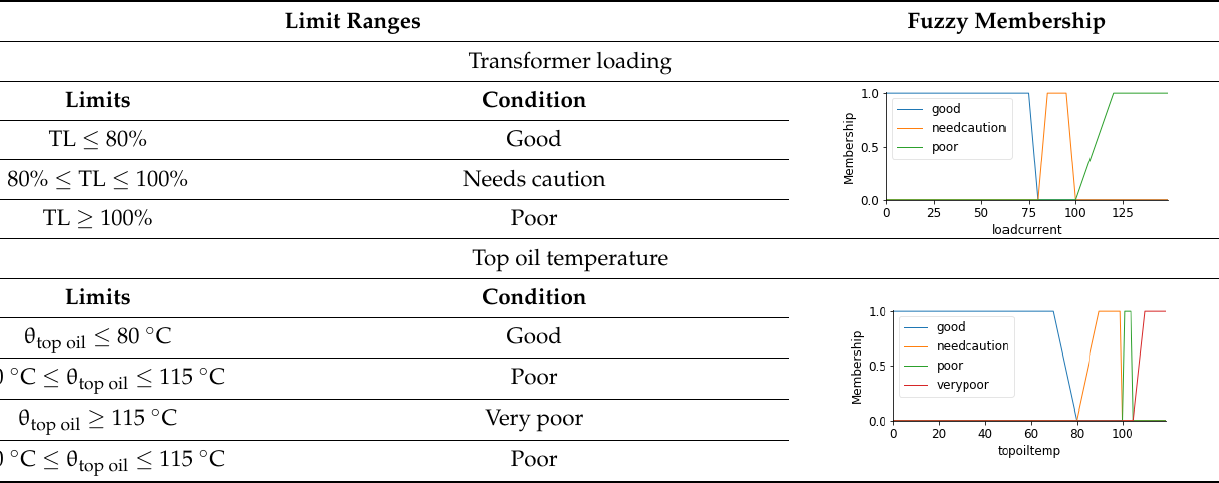
Table 1. Limit Ranges and Fuzzy Memberships.